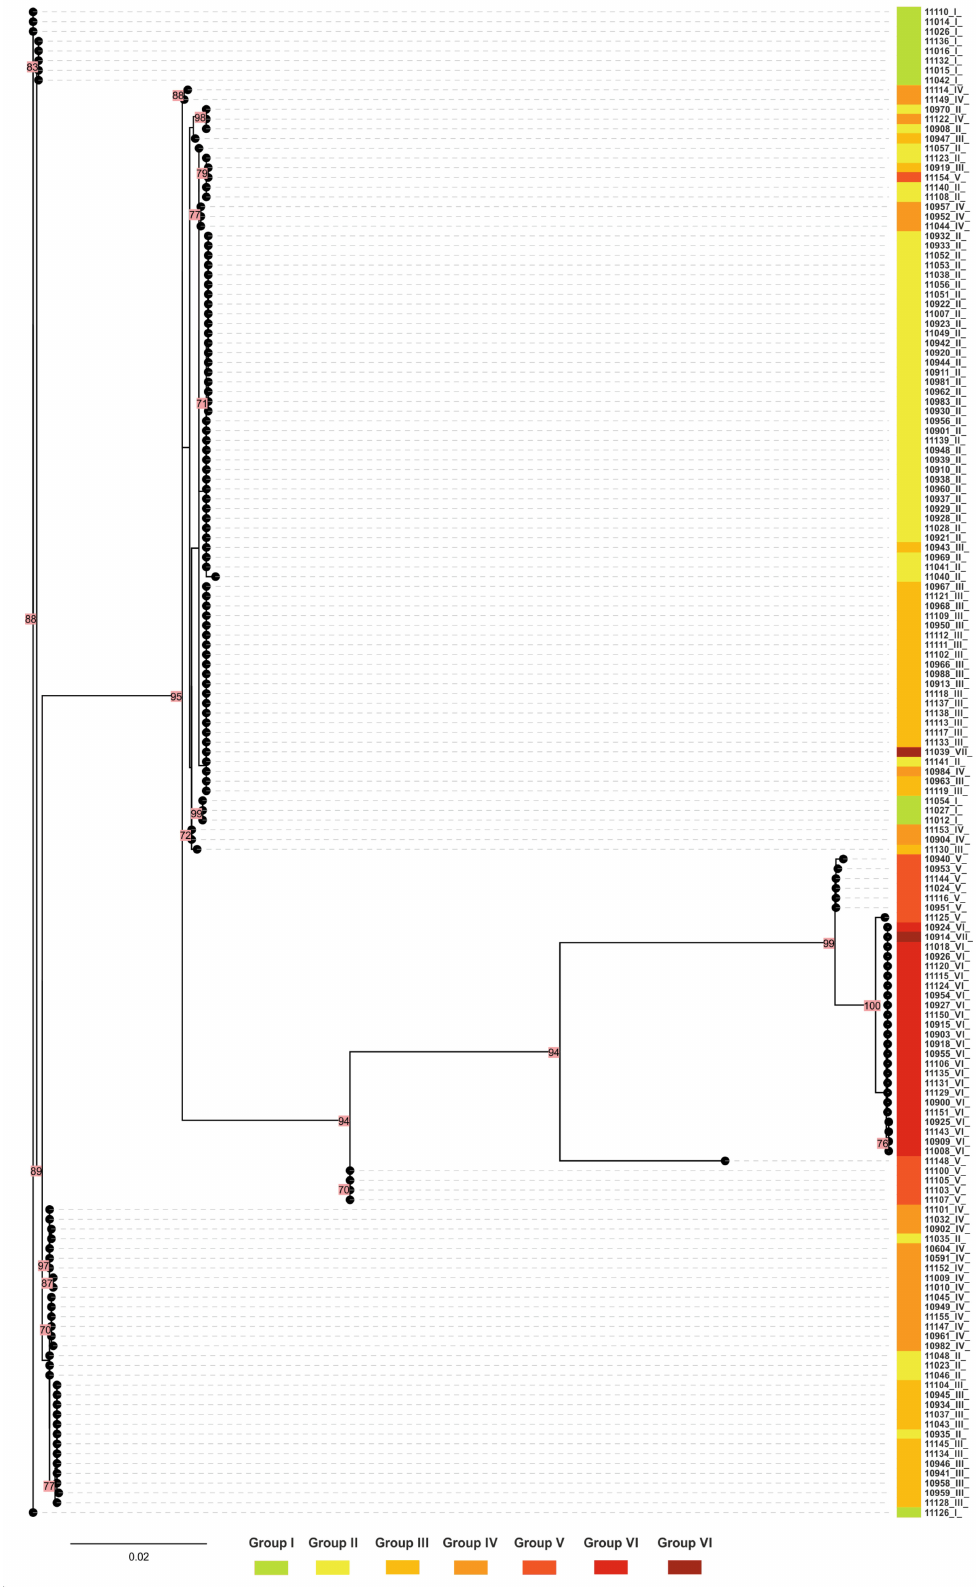
Figure 4. Maximum likelihood phylogenetic distance tree for concatenated mtrR and mtrD gene sequences of the N. gonorrhoeae isolates collected in Russia in 2020–2021. Isolate numbers are colored according to groups I-VII (Table 1, Figure 3). Bootstrap values of 70 or more are colored in